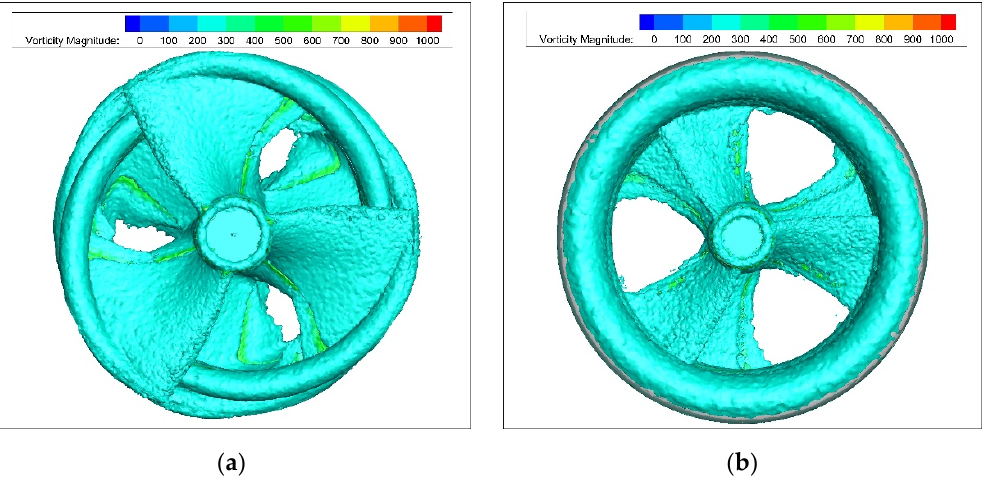
Figure 13. Pressure contour and streamline of coaxial propellers and ducted fan UAV: ( a ) Unducted propellers; ( b ) Ducted fan UAV.